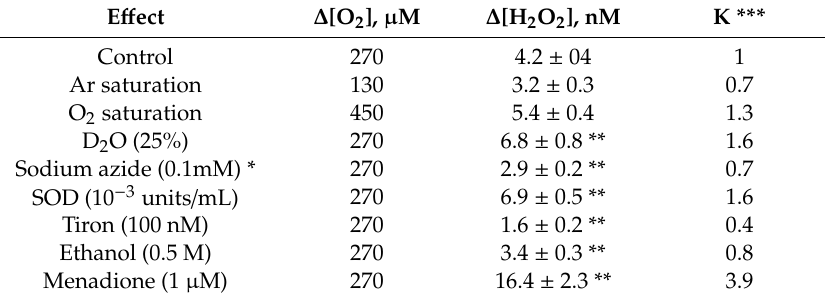
Table 1. The e ff ects of di ff erent substances on hydrogen peroxide formation in deionized water following 5-min exposure to mechanical stress (30 Hz, amplitude of 5 mm). The means for three independent assays and their standard errors are